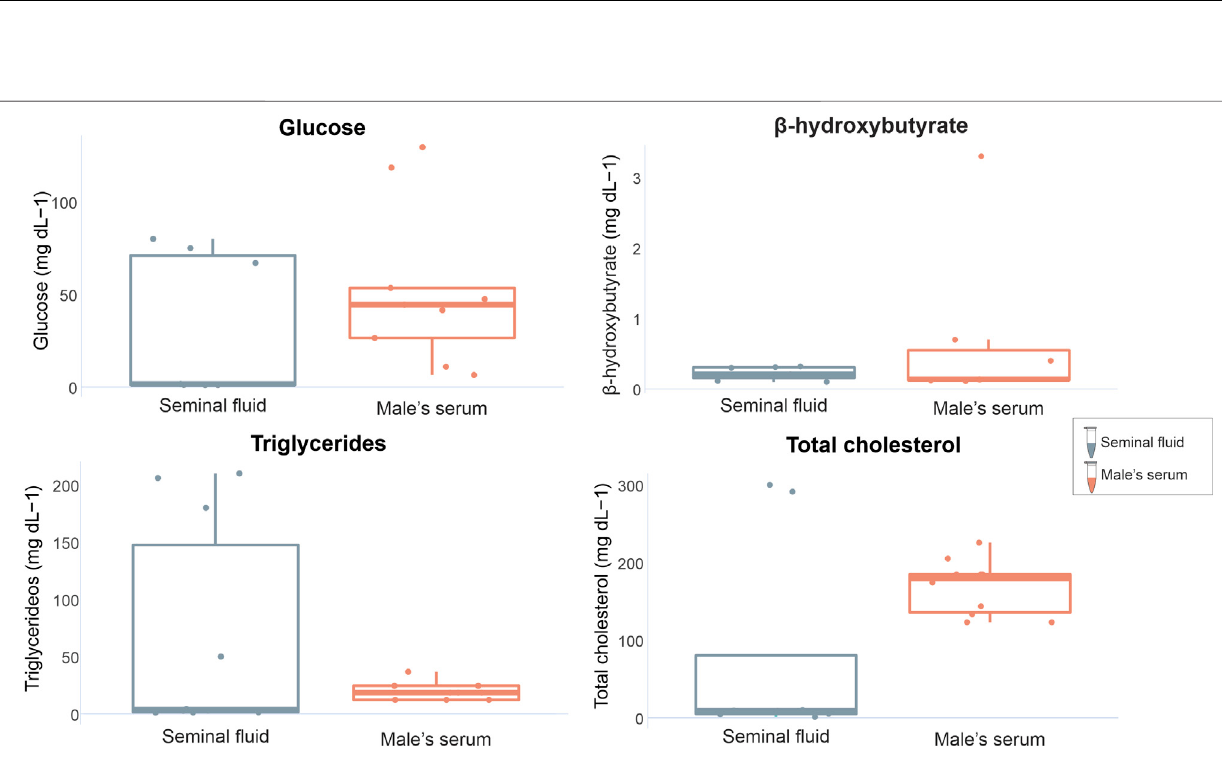
Frontiers in Physiology |